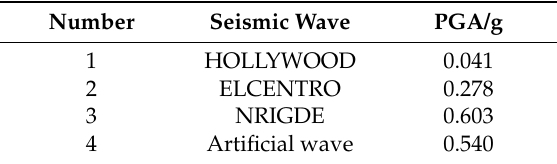
Table 6. PGA of seismic